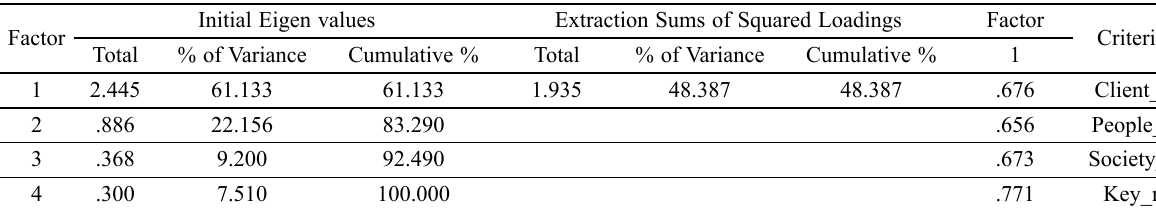
Table 7. Factor analysis of the result group Initial Eigen values Extraction Sums of Squared Loadings Factor Factor